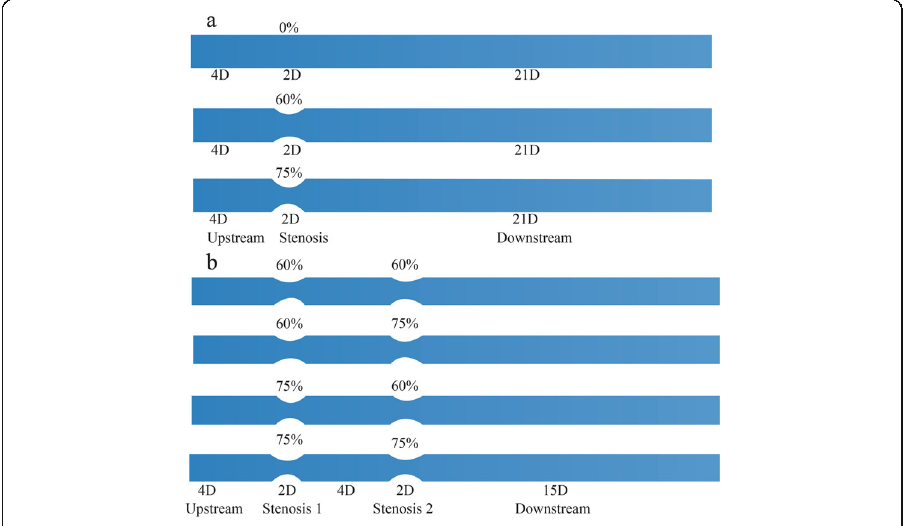
Fig. 1 Model artery without stenosis, with single stenosis ( a ) and double stenosis ( b ) with different area reductions for